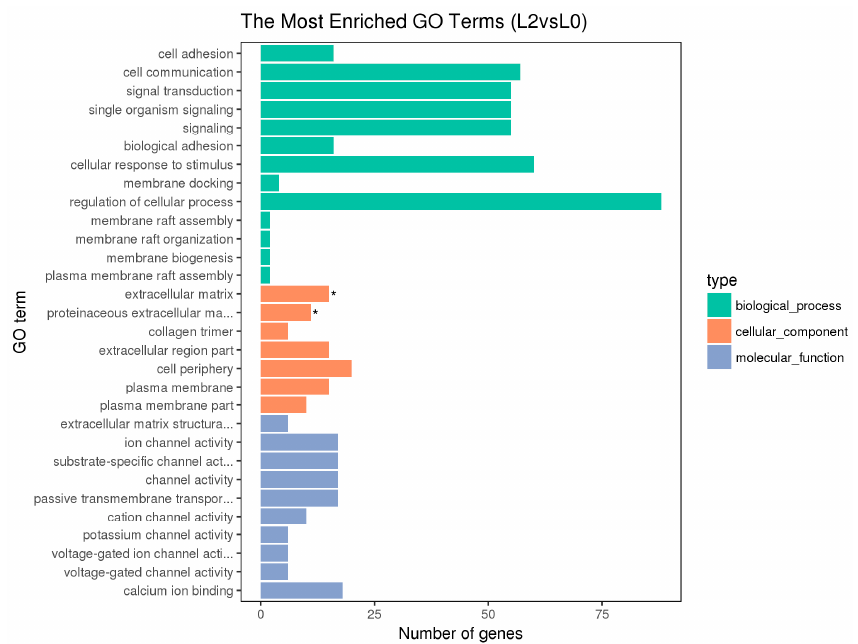
Figure 6. Histogram of GO enrichment of the ovarian DEGs. With “*” as the significantly enriched GO term. Table 3. Putative candidate genes of the DEGs associated with geese laying.